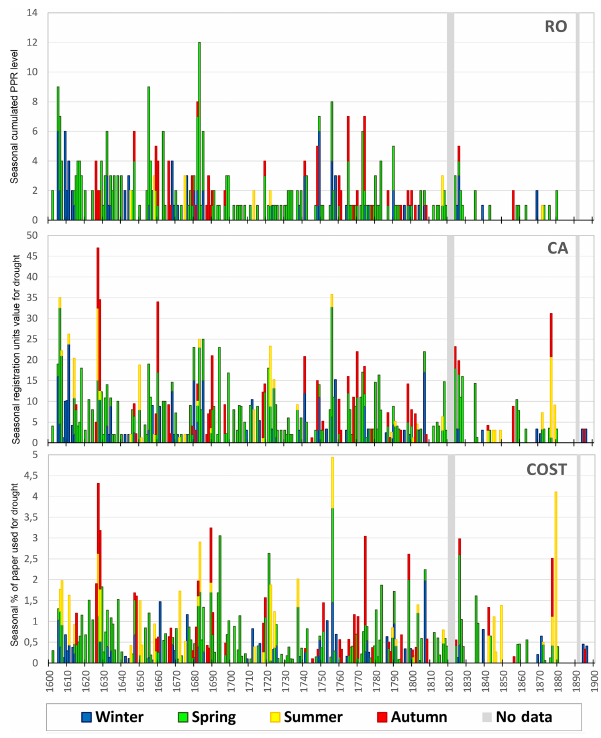
Figure 7. Seasonal drought variability in Caravaca between 1600 and 1900. Seasonal values accumulate for each year. In this way, the annual value is defined as the sum of the four seasonal values for a given year. The values on the y axis are in the unit that corresponds to each methodology, i.e. the sum of the pro pluvia RO levels for each station in RO, the sum of the values of RU for the drought in CA and the percentage of paper used for droughts during each season in COST. Note: data gaps (from 1820 to 1823 and 1891 to 1892) are shown in